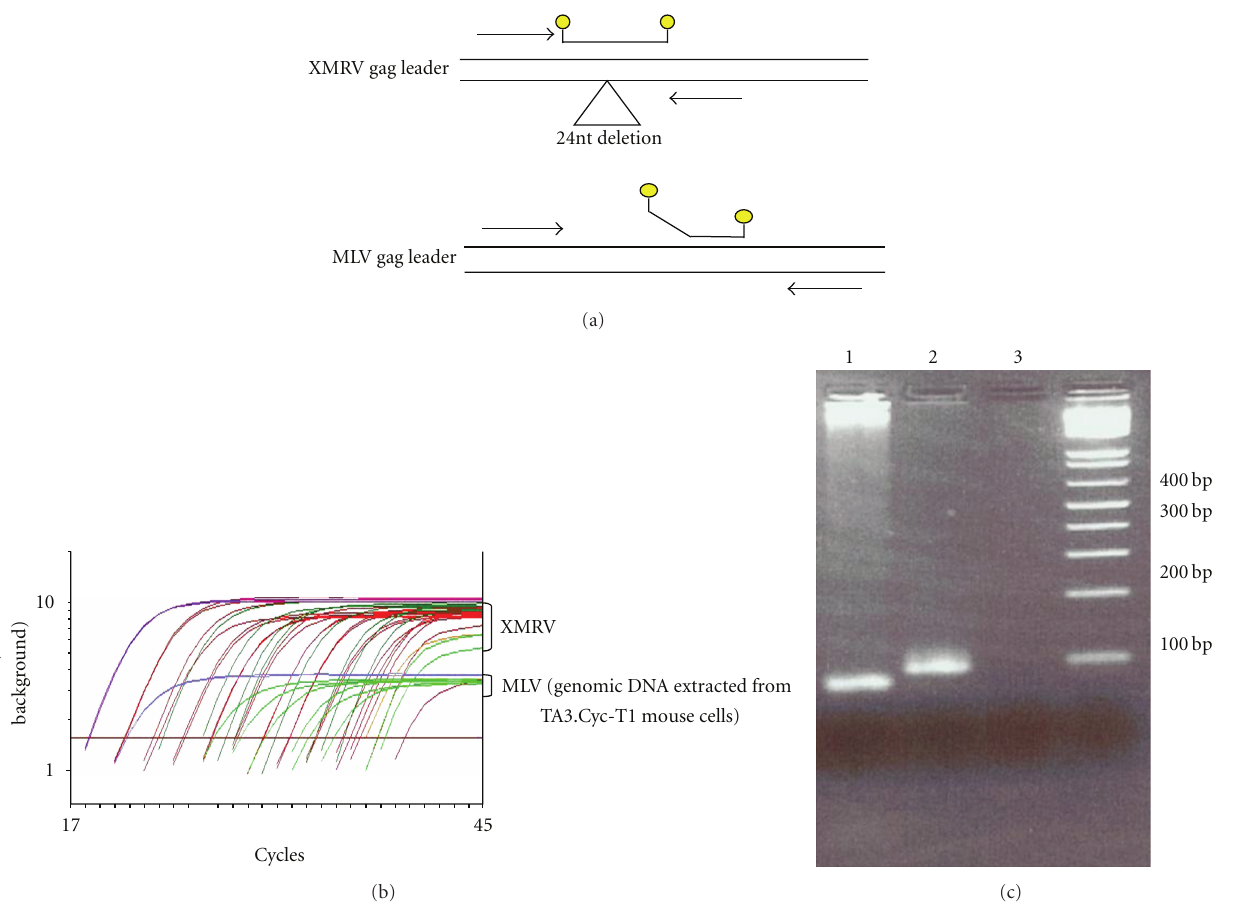
Figure 1: XMRV single-copy assay (X-SCA) . X-SCA primers anneal to conserved regions in XMRV/MLV gag leader region while the probe spans a 24 nt deletion in XMRV compared to MLV (a) allowing for di ff erential amplification profiles for XMRV and MLV (b). X-SCA amplification products run on a 2% agarose gel distinguish between the products being amplified since the XMRV product is 24 nt smaller than the MLV product. Lane 1 is the X-SCA product from the XMRV standard curve, Lane 2 is the MLV product from the genomic DNA extracted from TA3.Cyc-T1 mouse cells, and Lane 3 is the “no template” negative control